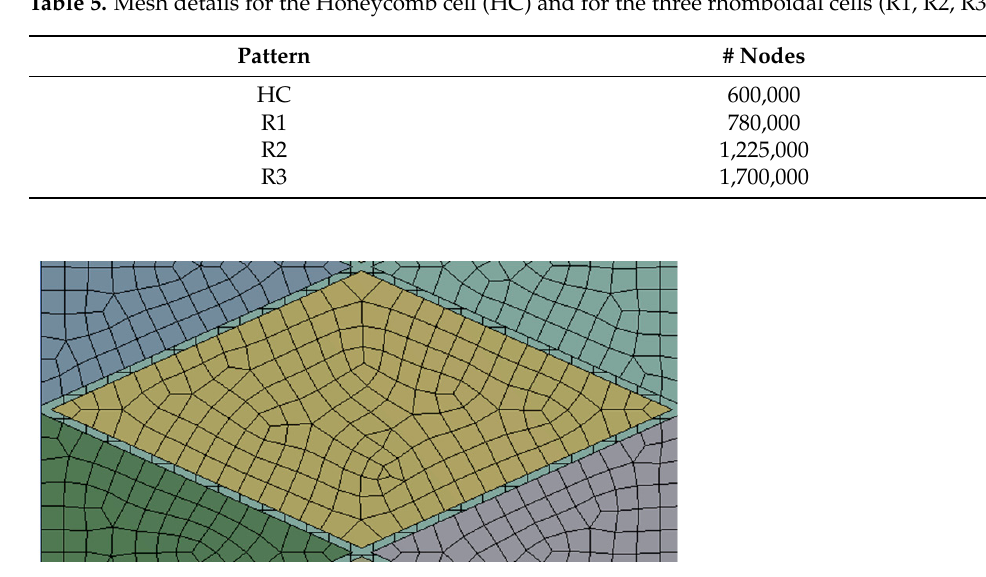
Figure 4. Mesh rhomboidal cell detail. Table 5. Mesh details for the Honeycomb cell (HC) and for the three rhomboidal cells (R1, R2, R3) Pattern